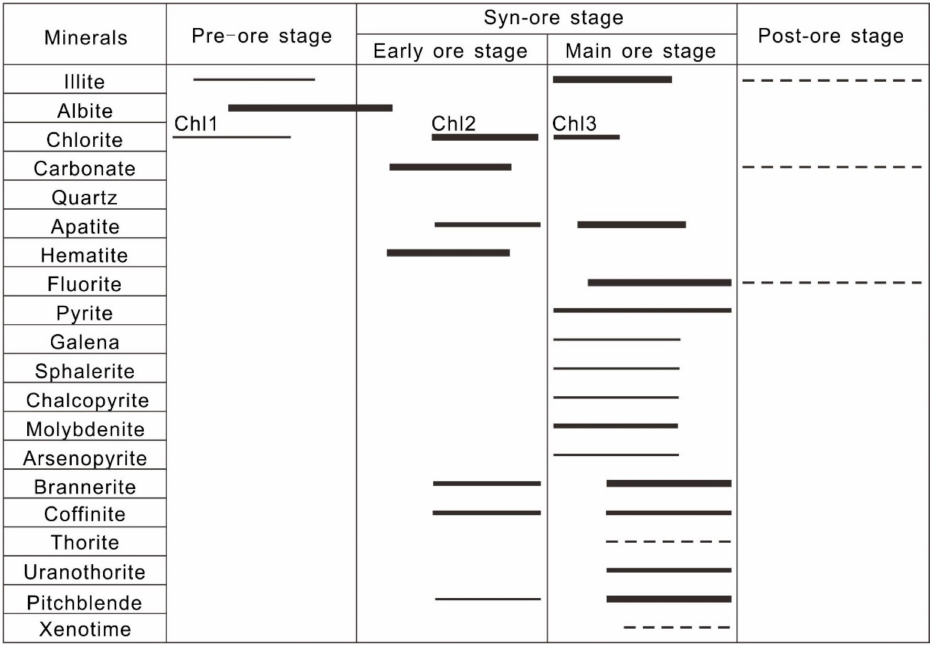
Figure 3. Paragenetic sequence of altered and ore minerals at Xiangshan uranium ore